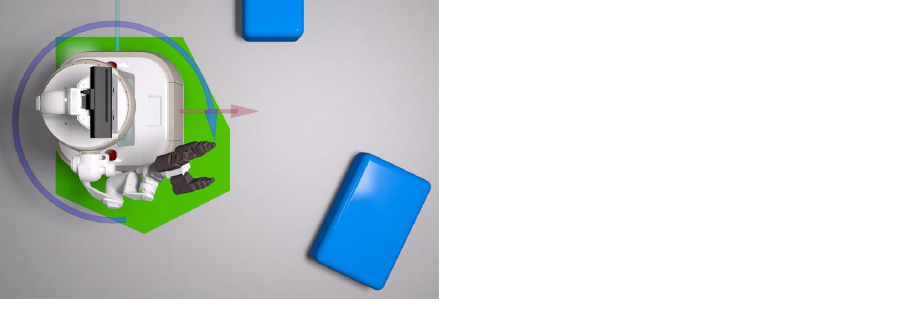
Figure 6. The robot collision space is projected onto the ground as a convex polygon (green surface) to locally navigate around obstacles (blue boxes). The arrows indicate the robot’s navigational DoF.